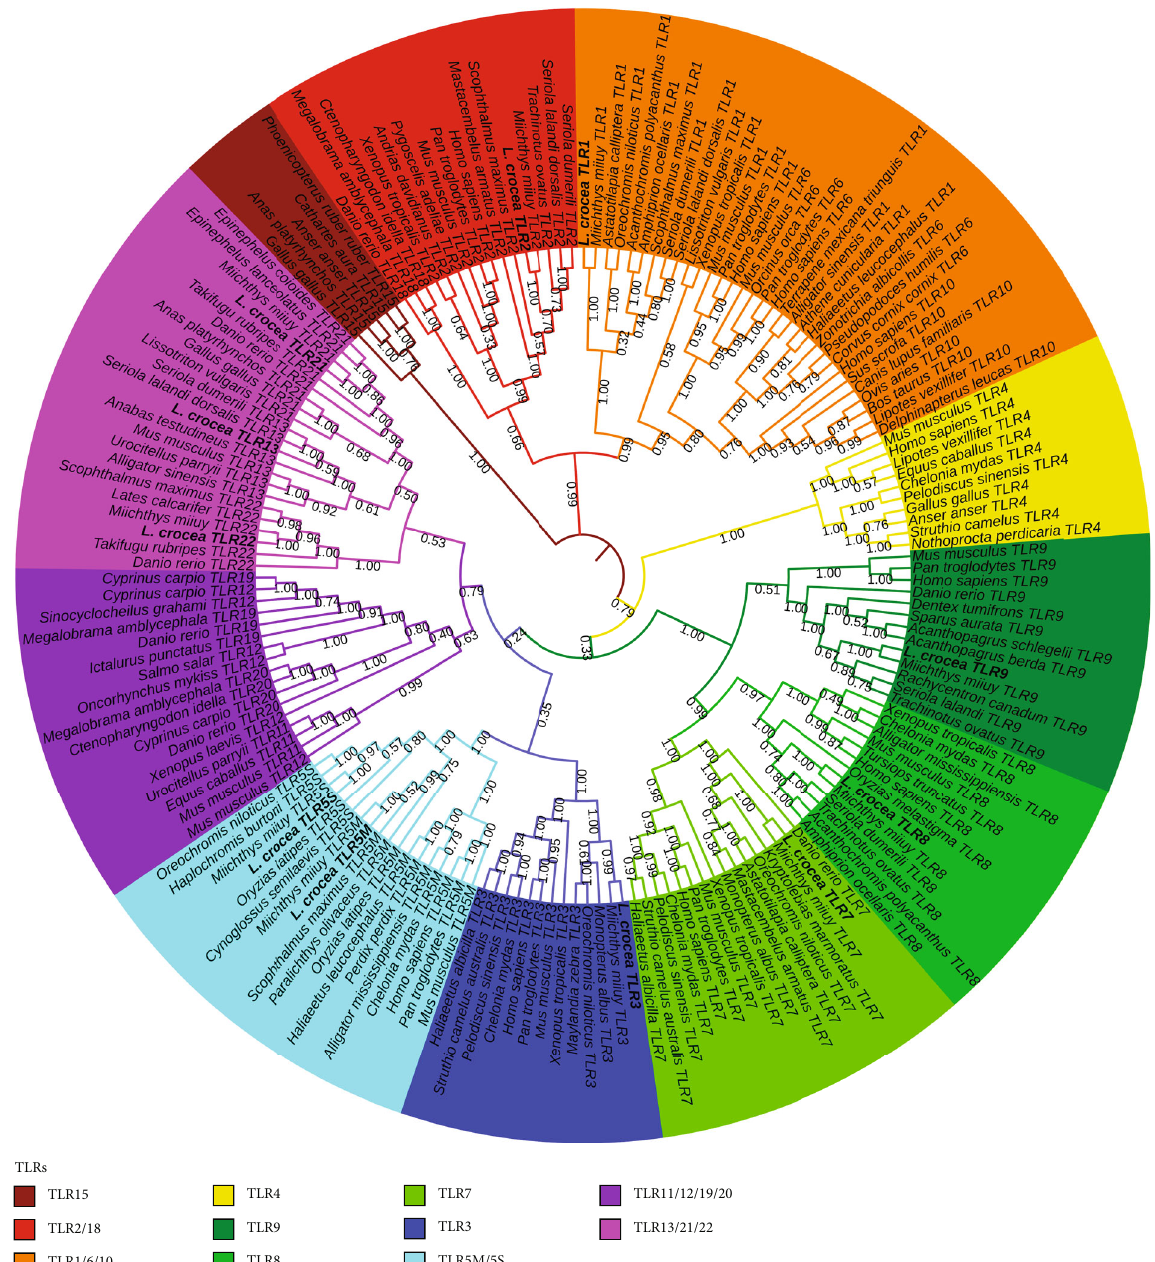
Figure 5: Phylogenetic tree of TLRs based on full-length amino acid sequences. Phylogenetic trees were constructed based on the amino acid sequences of TLRs from fi sh, birds, and mammals using the neighbor-joining method in MEGA 7. Numbers on the branches represent the percentage of bootstrap values. Node values represent the bootstrap con fi dence from 10,000 replicates. The GenBank accession numbers of the sequences are listed in Table 1. All TLRs were clustered into 4 groups, in which TLR15 and TLR4 were grouped separately (TLR15 group and TLR4 group), TLR1, 2, 6, 8, and 10 were clustered together (TLR1 group), and the remaining TLRs formed a large group (TLR3, TLR5M/S, TLR7, TLR8, TLR9, TLR11, TLR12, TLR13, TLR19, TLR20, TLR21, and TLR22). The large groups of 13 TLRs could